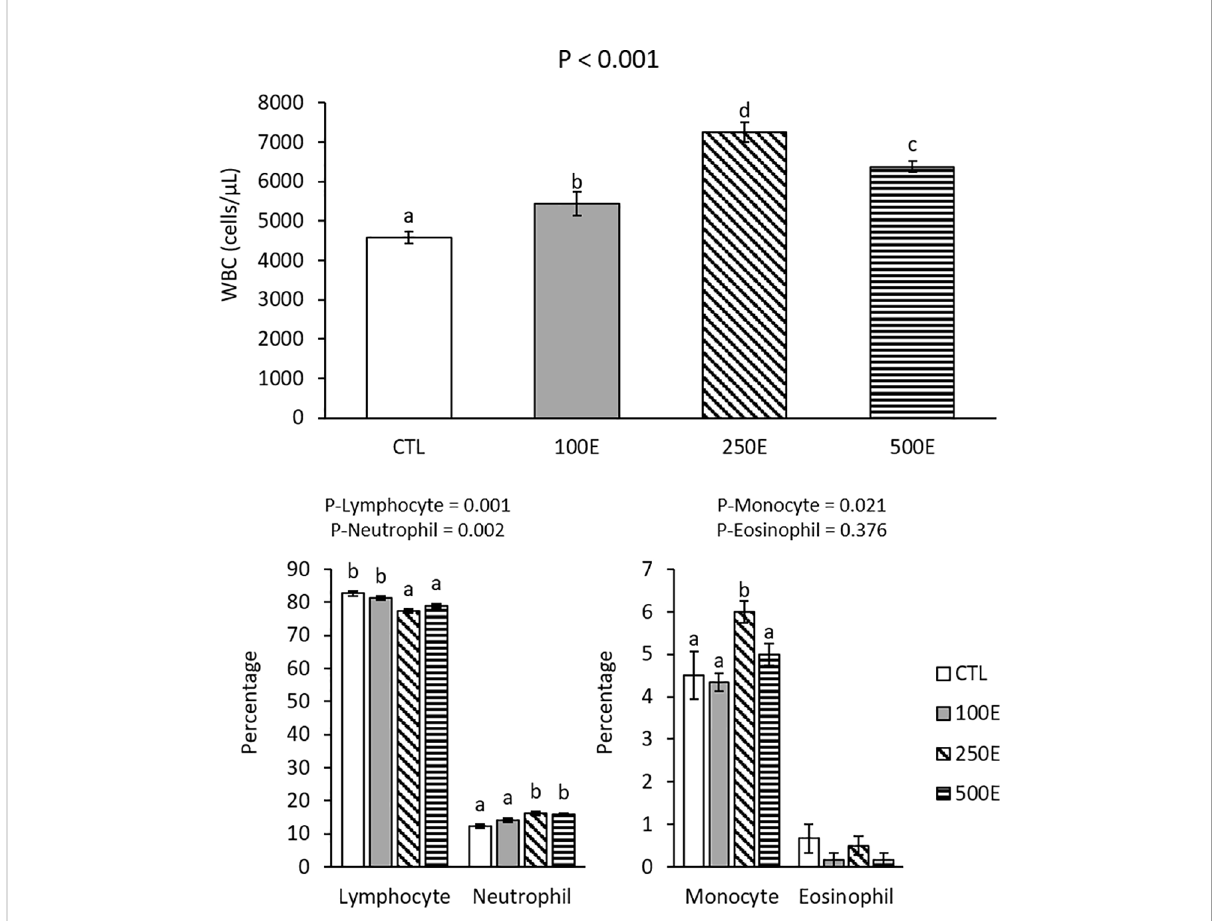
FIGURE 2 WBC and differential leukocyte count (mean ± SE) of rainbow trout fed diets supplemented with 0-500 mg/kg HE over eight weeks. Different letters above the bars indicate signi fi cant differences among the treatments (Duncan test for WBC and Mann-Whitney U test for differential counts; n =